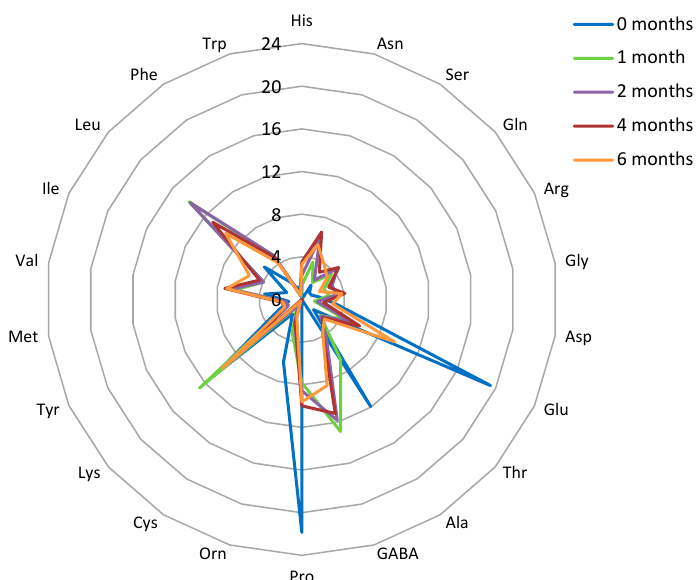
Figure 4. Radar diagram showing the relative content of individual free amino acids (FAA) during six months of RO-cheese ripening (mol%). Results presented are the means of two measurements. Amino acids: GABA, γ -aminobutyric acid; Ala, alanine; Thr, threonine; Glu, glutamate; Asp, aspartate; Gly, glycine; Arg, arginine; Gln, glutamine; Ser, serine; Asn, asparagine; His, histidine; Trp, tryptophan; Phe, phenylalanine; Leu, leucine; Ile, isoleucine; Val, valine; Met, methionine; Tyr, tyrosine; Lys, lysine; Cys, cysteine; Orn, ornithine; and Pro, proline.